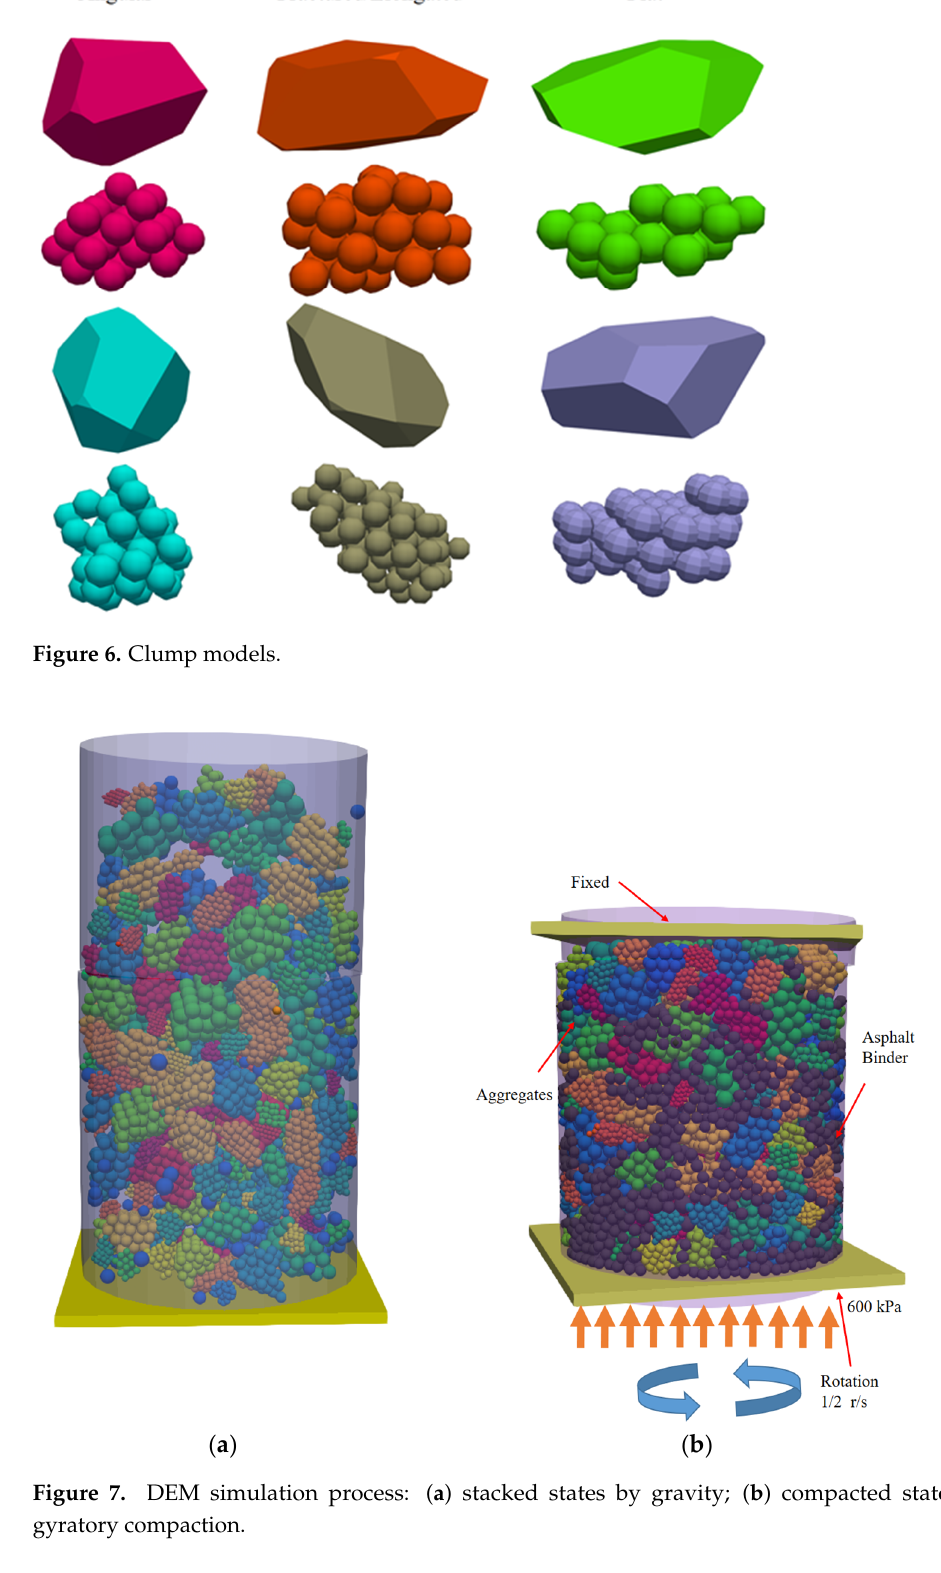
Figure 5. Particle reconstruction based on Voronoi tessellation: ( a ) basic particle shape generation; ( b ) spindle tension and rotation for shape adjustment; ( c ) 3D particle shape for simulation.